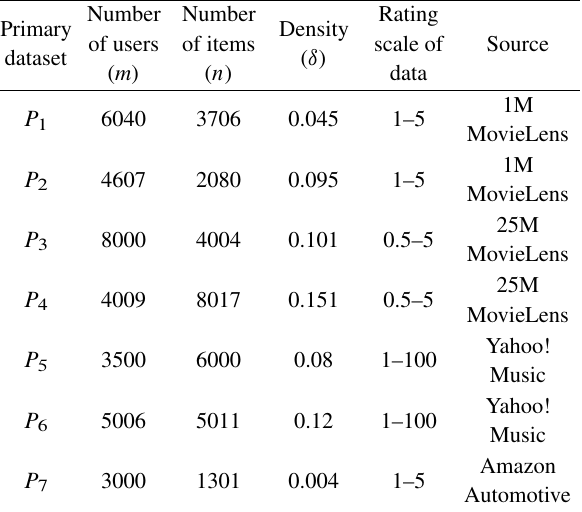
Table 2 Details of primary rating matrices used during study.